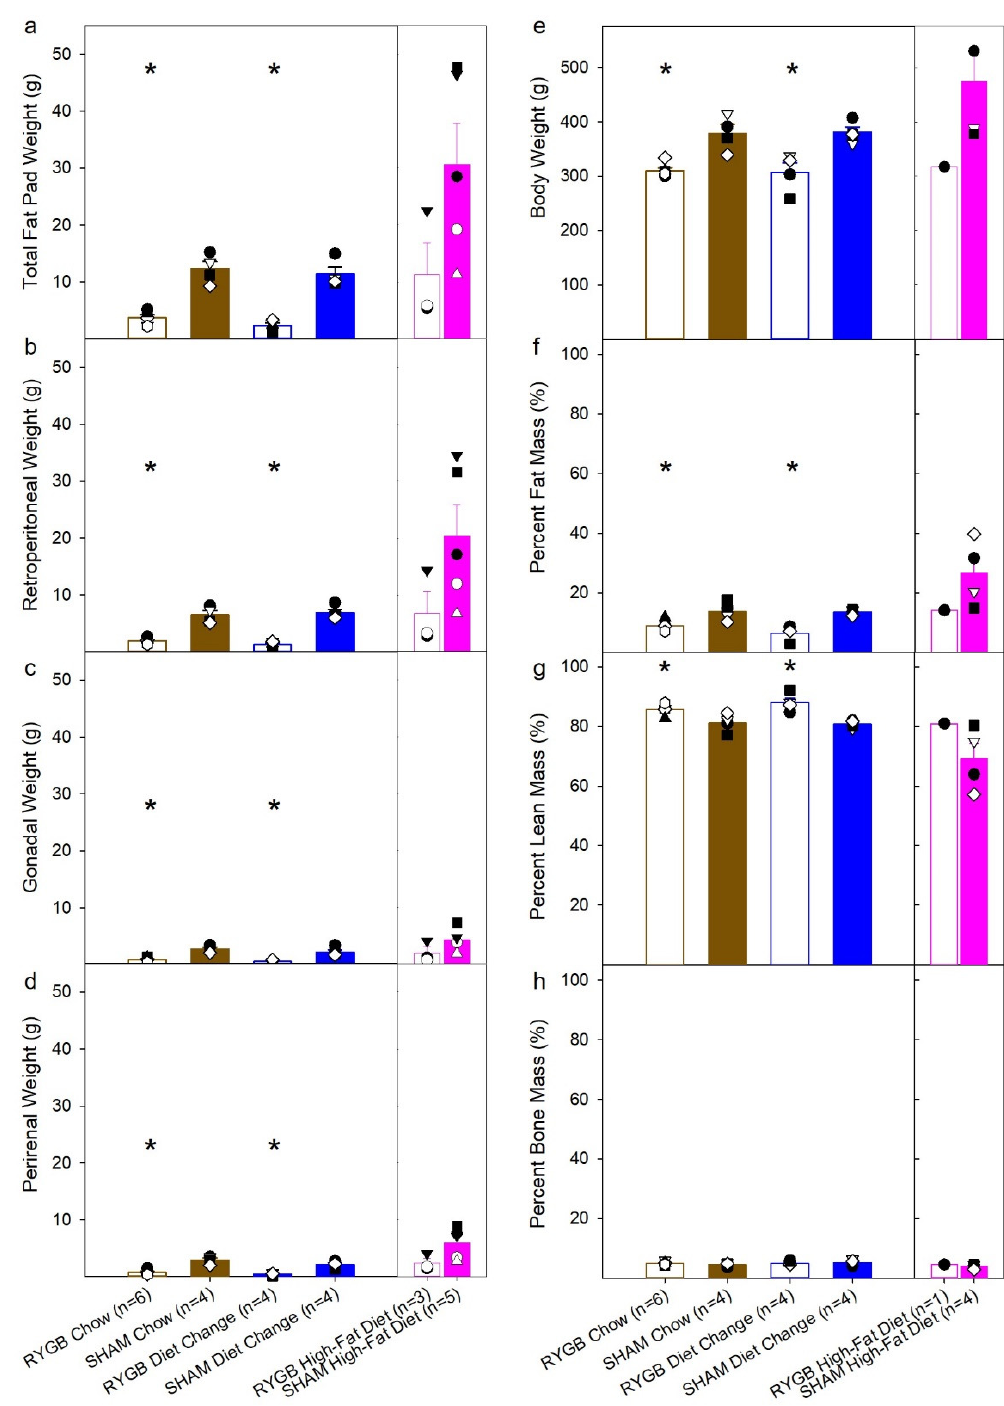
Figure 4. Mean ( ± SE, standard error) and individual animal data for total fat pad weight ( a ) and weights of the retroperitoneal ( b ), gonadal ( c ), and perirenal fat pads ( d ); the mean ( ± SE) of the body weight on the day of the EchoMRI scan ( e ); and the percent fat ( f ), lean ( g ), and bone ( h ) mass from the animals in Phase 2. Diet groups are represented as brown for the Chow group; blue, the diet change; pink, the high-fat diet. RYGB group means within each diet condition are represented by open bars, SHAM by filled bars. Due to low group size, the HFD RYGB group could not be included in the statistical analyses and is represented in a separate panel along with its sham-operated control group, which was included in some analyses. Significant differences from paired comparisons (that survived Bonferroni corrections) between the surgical groups within a diet are represented with “*”.